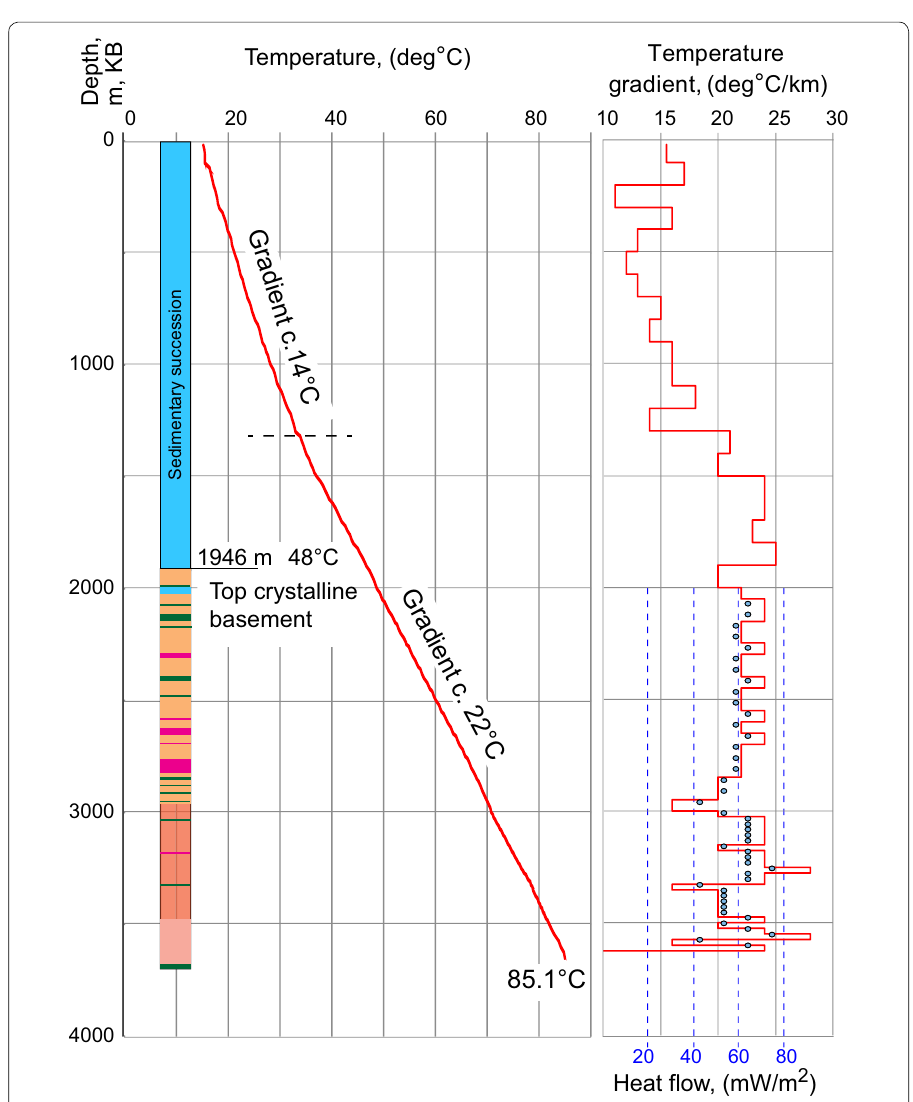
Fig. 8 Graphs showing the temperature profile and temperature gradients in the DGE‑1 well. The calculated heat flow is shown for the crystalline section below 2000